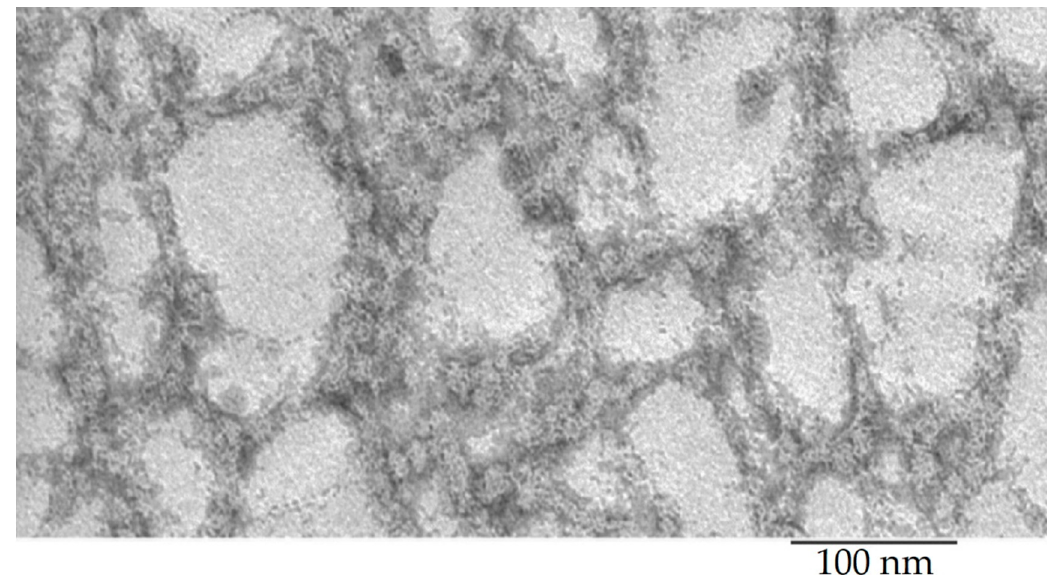
Figure 2. Electron microscopic image of the bPaS1 protein under conditions of 50 mM TrisHCl, pH 8.0; 100 mM NaCl; 10 mM MgCl 2 ; 5 mM β -mercaptoethanol.